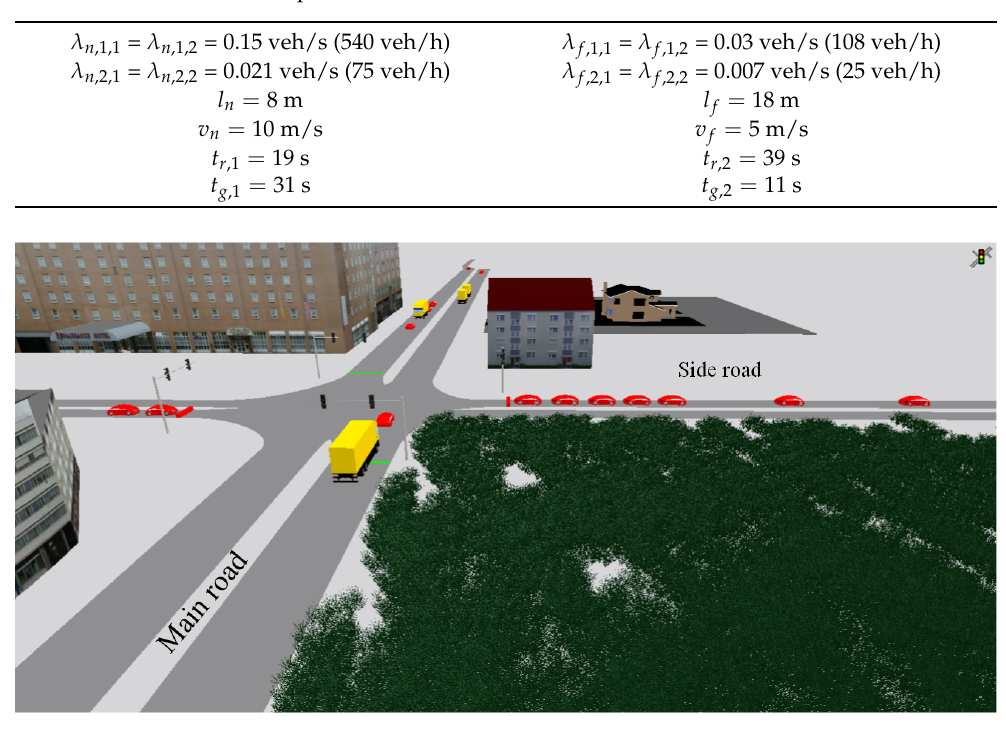
Figure 3. An illustration of the layout used for the basic intersection.